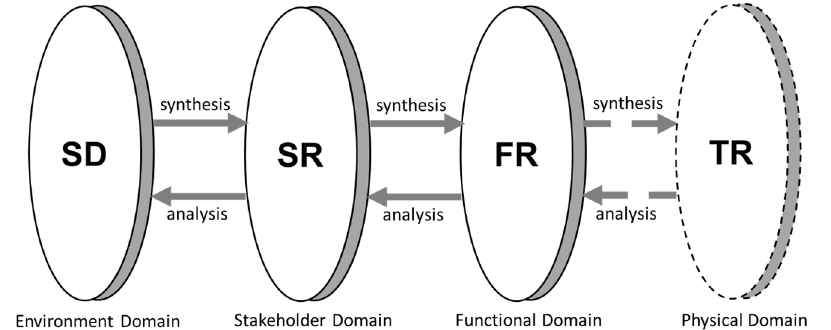
Figure 2. Domains of the design world (adapted from [13]).